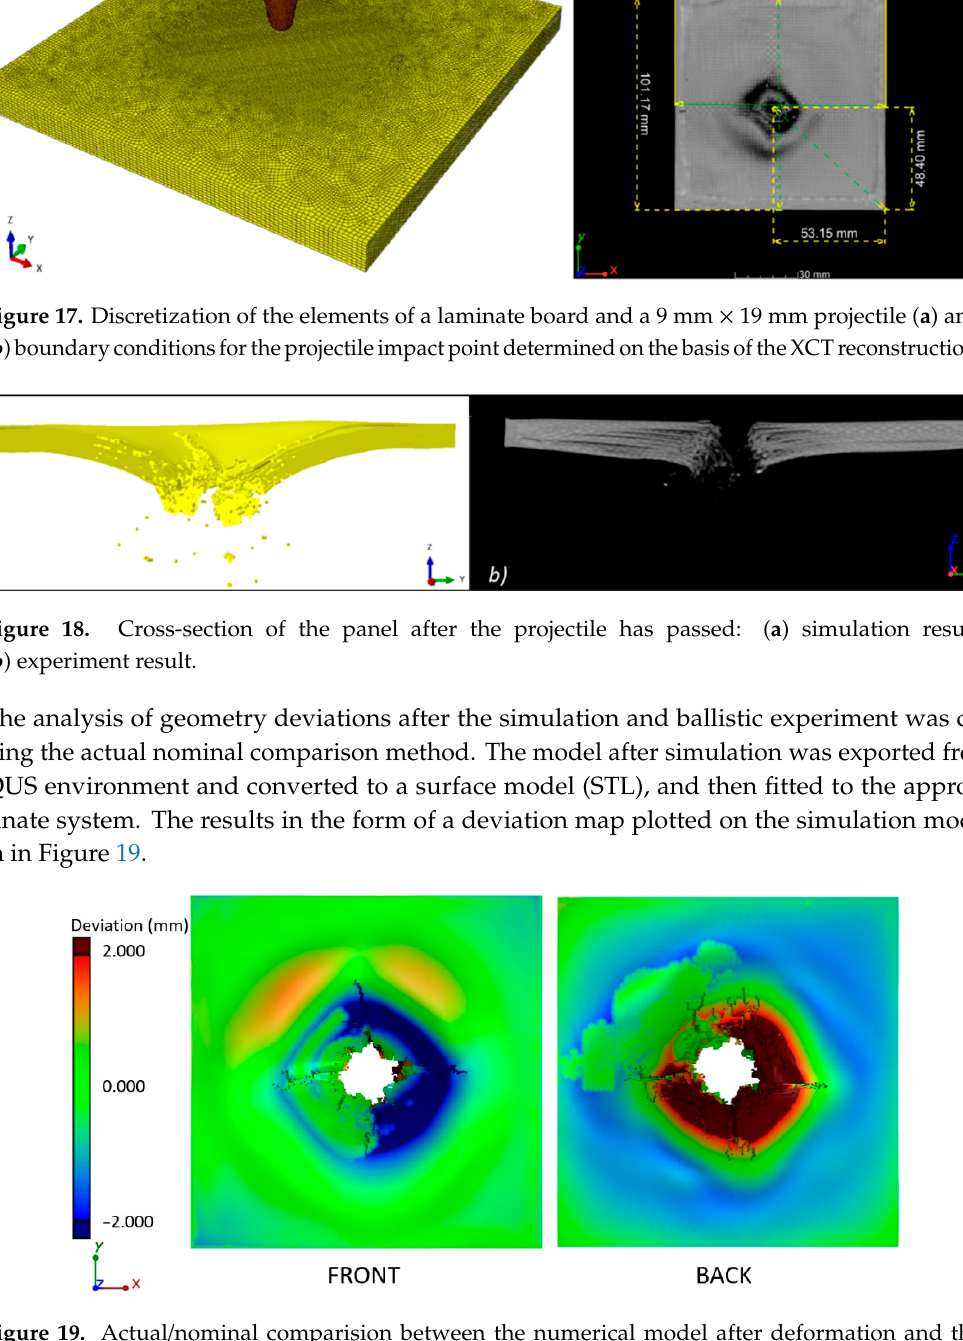
Figure 19. Actual/nominal comparision between the numerical model after deformation and the experiment results after deformation.